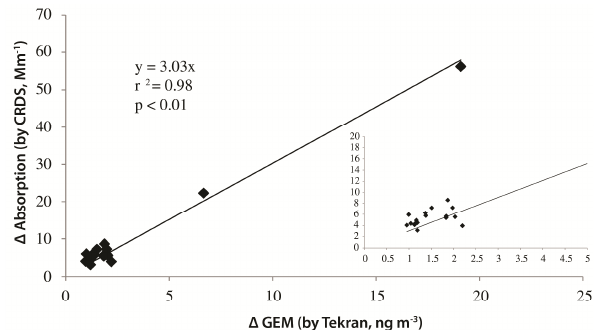
Fig. 6. Scatterplots between Tekran and CRDS measurements dur- ing a calibration in ambient air performed 19 July 2012. The inset shows data from 0 to 5ngm − 3